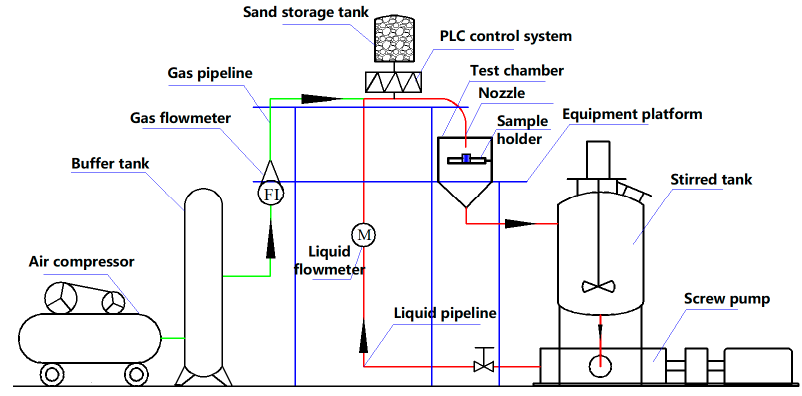
Figure 1. Gas–solid and liquid–solid experimental loop.